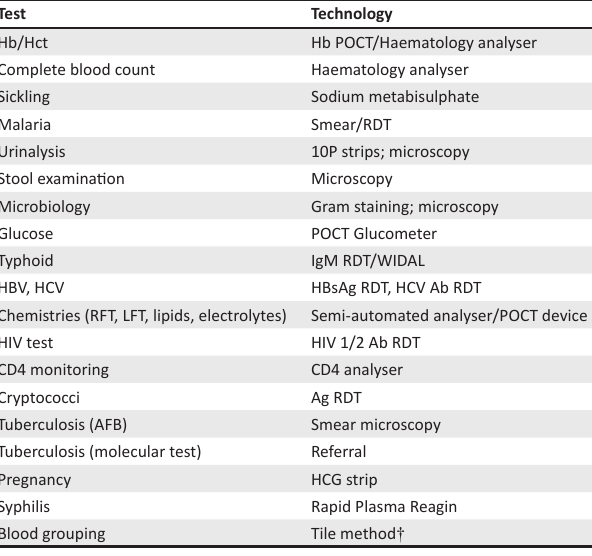
TABLE 1: Diagnostic testing menu for Koidu Government Hospital central laboratory, Sierra Leone,